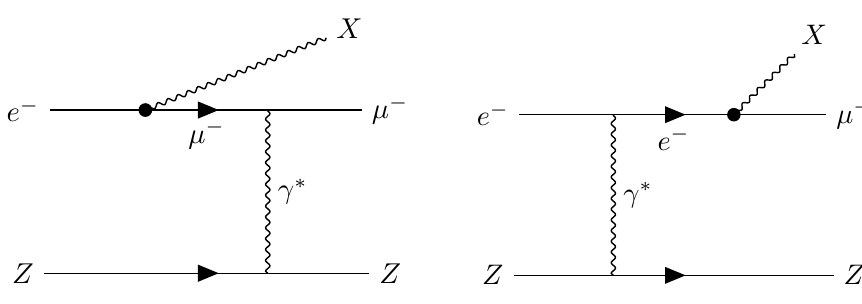
Figure 1 . Light boson production through bremsstrahlung process with CLFV interaction by a target with the atomic number Z . The boson X is either a (pseudo)scalar or